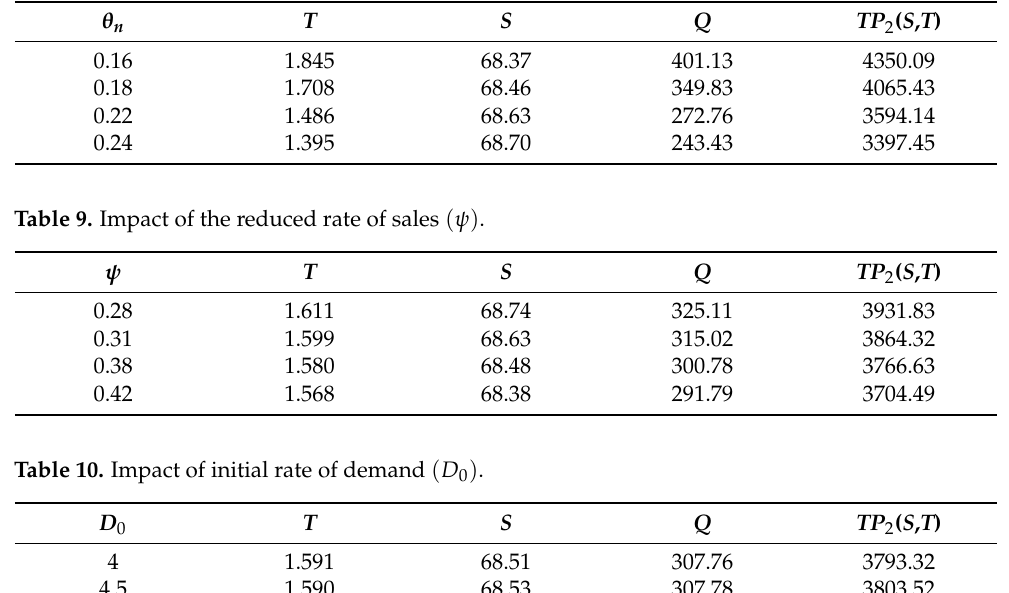
Table 8. Impact of deterioration rate ( θ n ) .